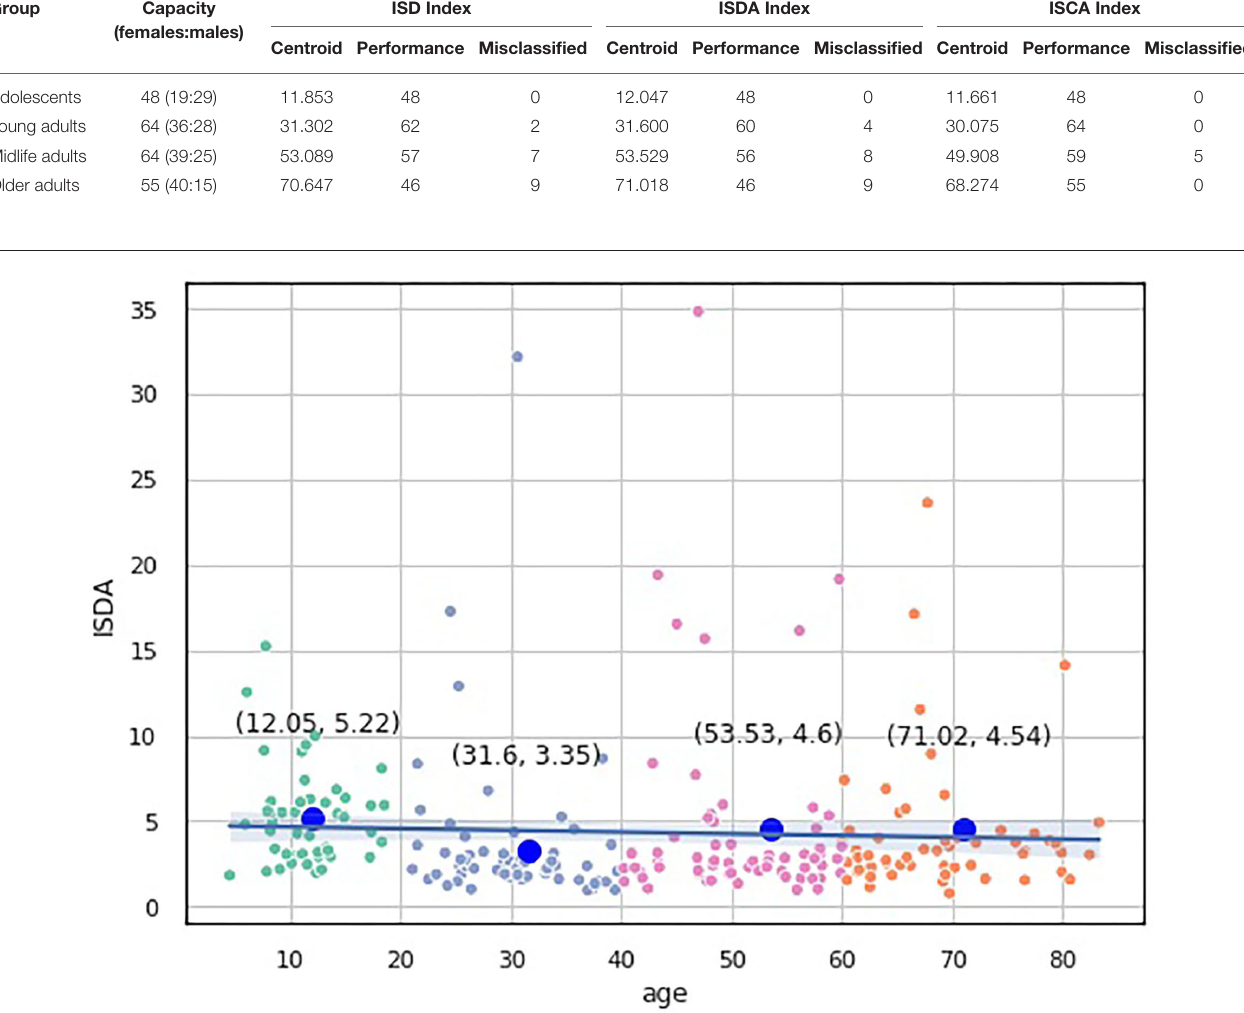
FIGURE 6 | Over-the-age distribution of ISDA values.